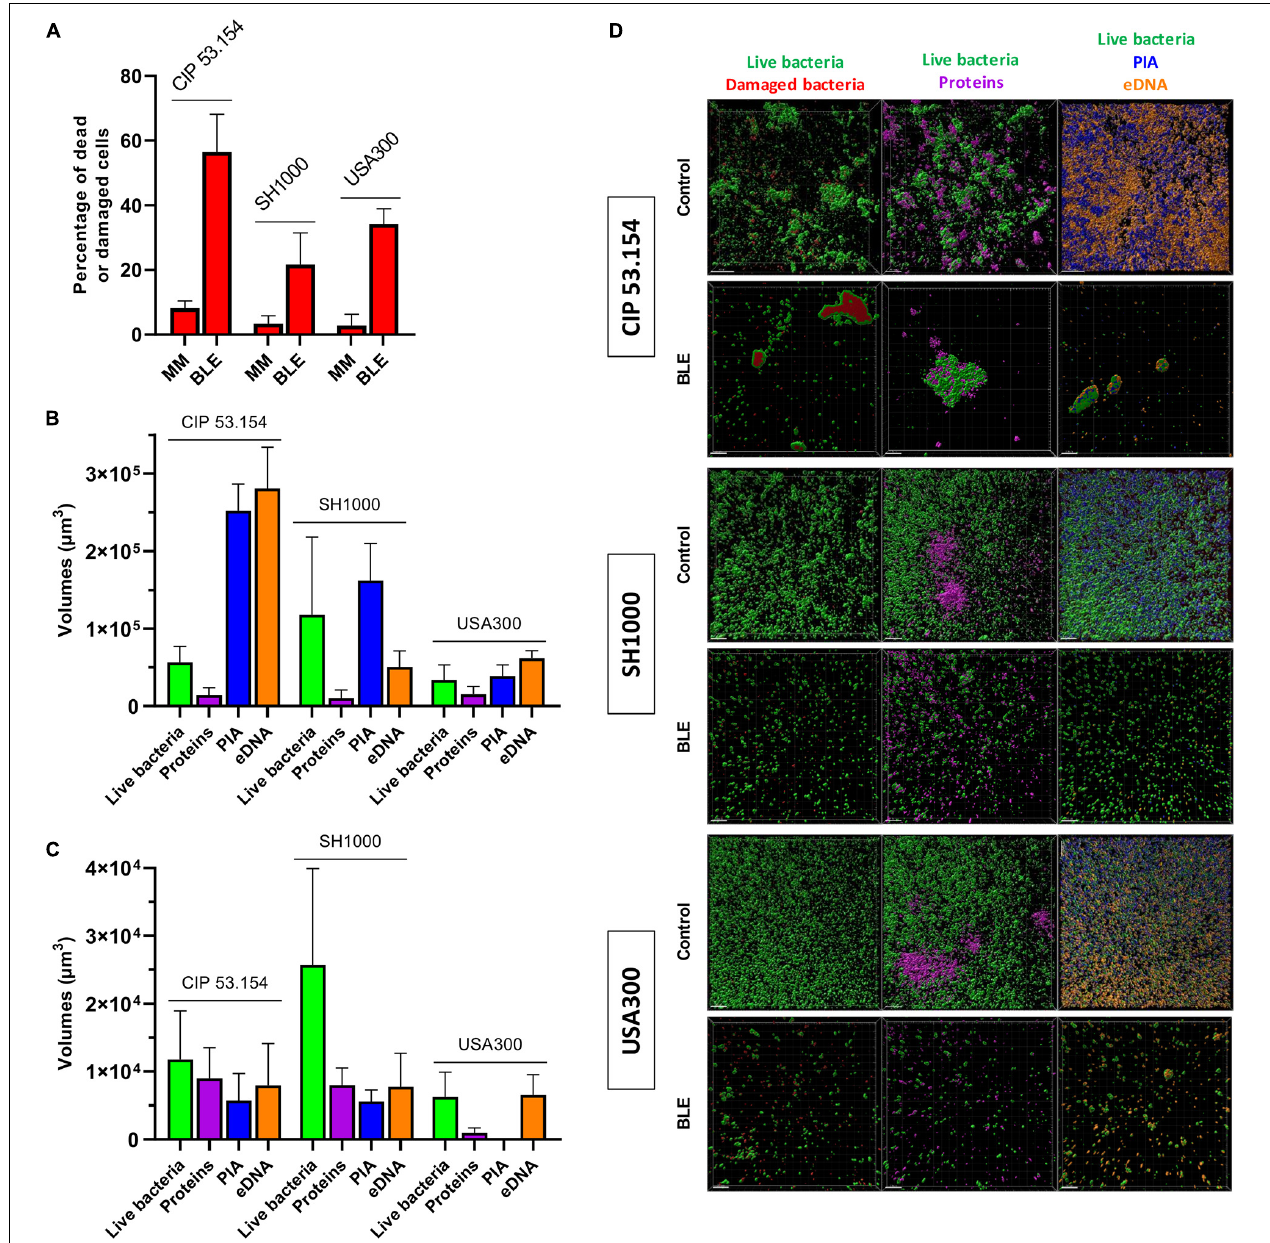
FIGURE 6 | Impact of starvation, magnesium excess, and hypoxia on S. aureus biofilm matrix components. Biofilms were grown in minimal medium (MM) or modified minimal medium (BLE: no CAA, without casamino acids; 10 × Mg, 10 × minimal medium concentration; no Gluc, without glucose) without oxygen for 24 h before confocal scanning electron microscopy imaging. (A) Results represent the percentage of dead or damaged bacteria (stained by PI) among live bacteria (stained by SYTO TM 9). (B) Results represent the volume measurement of SYTO TM 9 (green histograms; live bacteria), SYPRO R (cid:13) Ruby (magenta: protein), WGA (blue: PIA) and TOTO TM -3 (orange: extracellular DNA) of bacteria grown in MM without oxygen. (C) Results represent the volume measurement as previously described in BLE without oxygen. (D) Representative images are shown. Experiments were performed two independent times with three representative acquisitions for each coverslip. Error bars represent standard errors for each average value. Scale bar = 20 µ